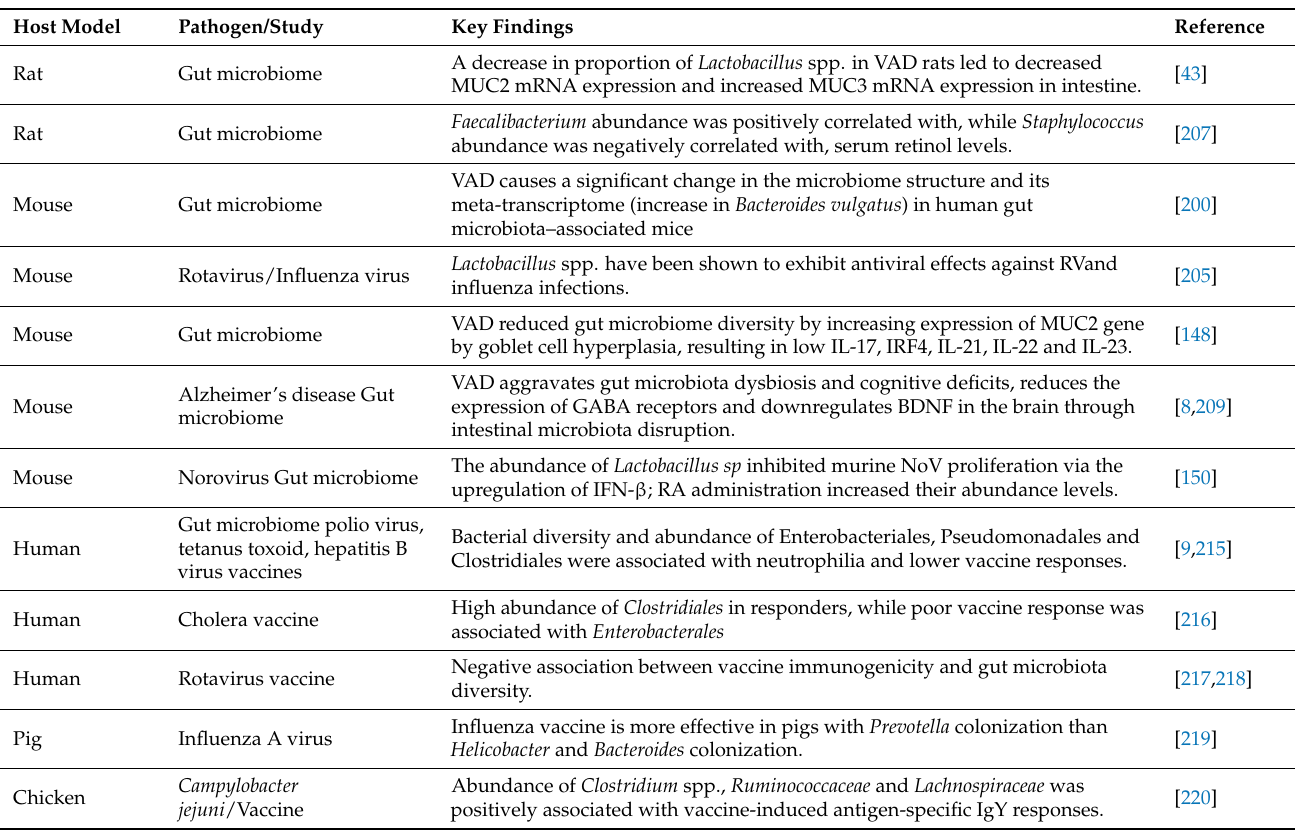
Table 3. Clinical studies and animal model research on interactions between VAD, gut microbiota and impaired immune responses to infectious diseases and